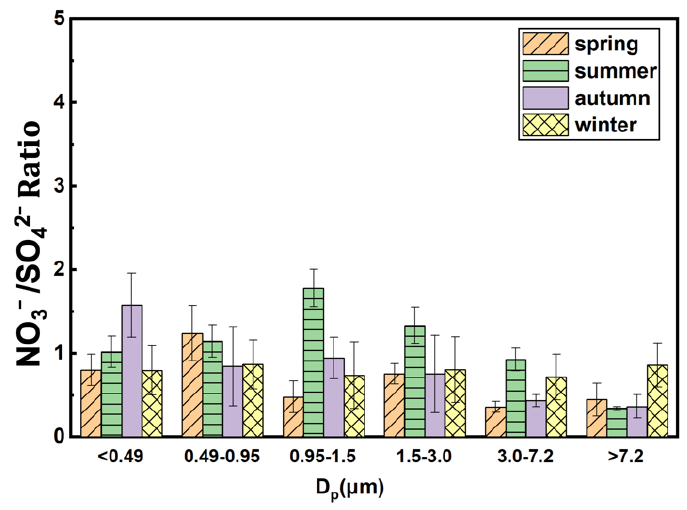
Figure 6. Size distribution of [NO 3 − ] − [SO 4 2− ] ratio during different seasons.